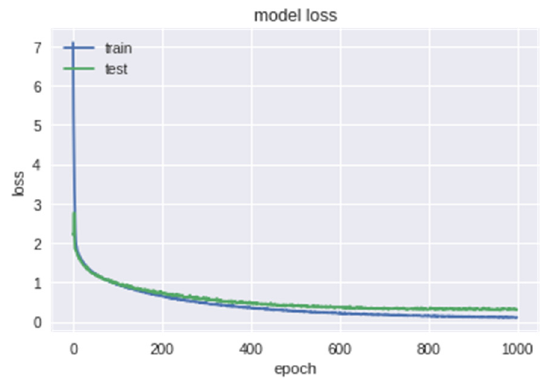
Figure 11. Loss of epochs based on training and test data.